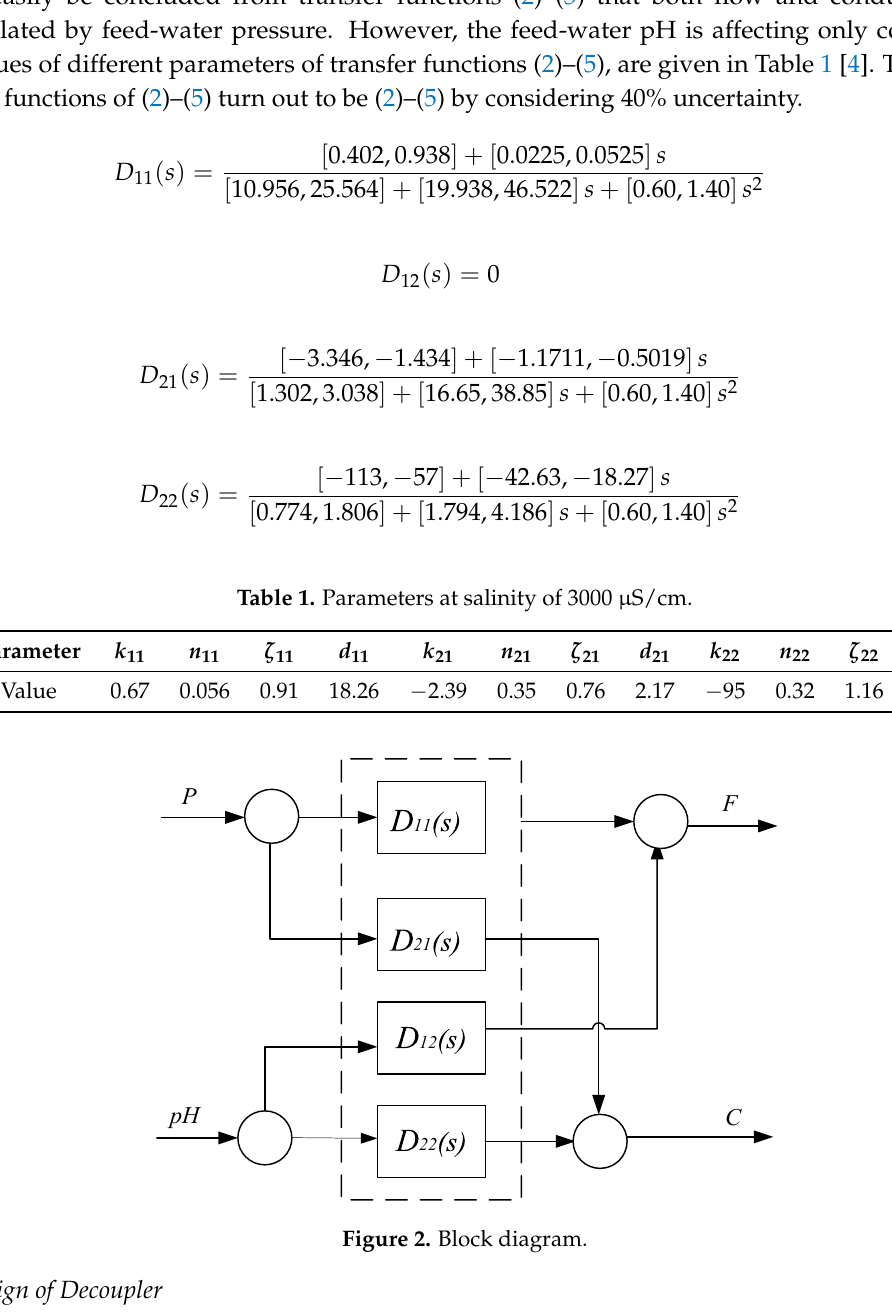
Table 1: Values of different parameters.